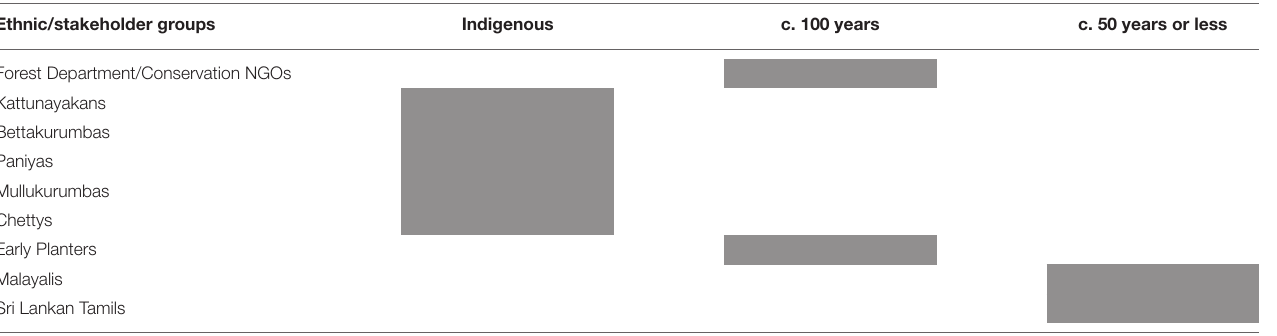
TABLE 6 | Varying history of living with